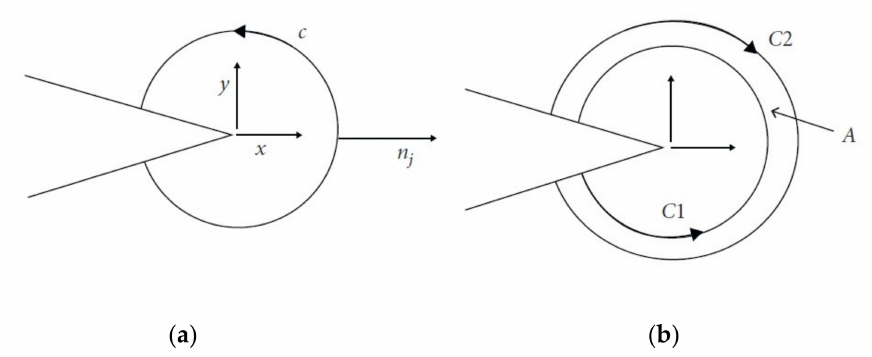
Figure 3. ( a ) Crack tip in an arbitrary contour, ( b ) J -integral